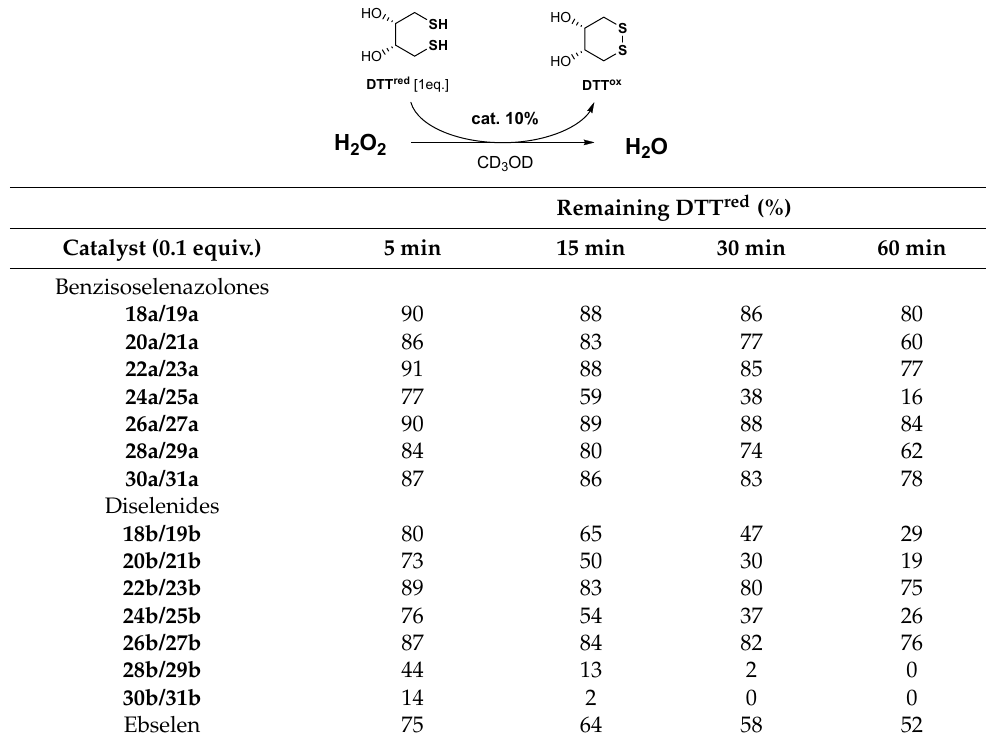
Figure 3. Molecule 1 of 24a with atomic displacement parameters plotted at a 50% probability level. The atom-numbering scheme is analogous for all molecules in both enantiomers 24a and 25a . Table 1. Results of the antioxidant activity measurement.